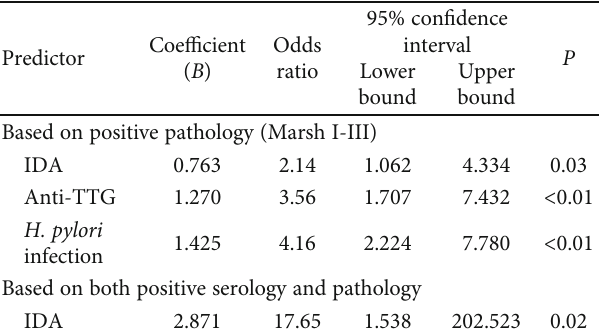
Table 2: Multivariate logistic regression model for the prediction of celiac